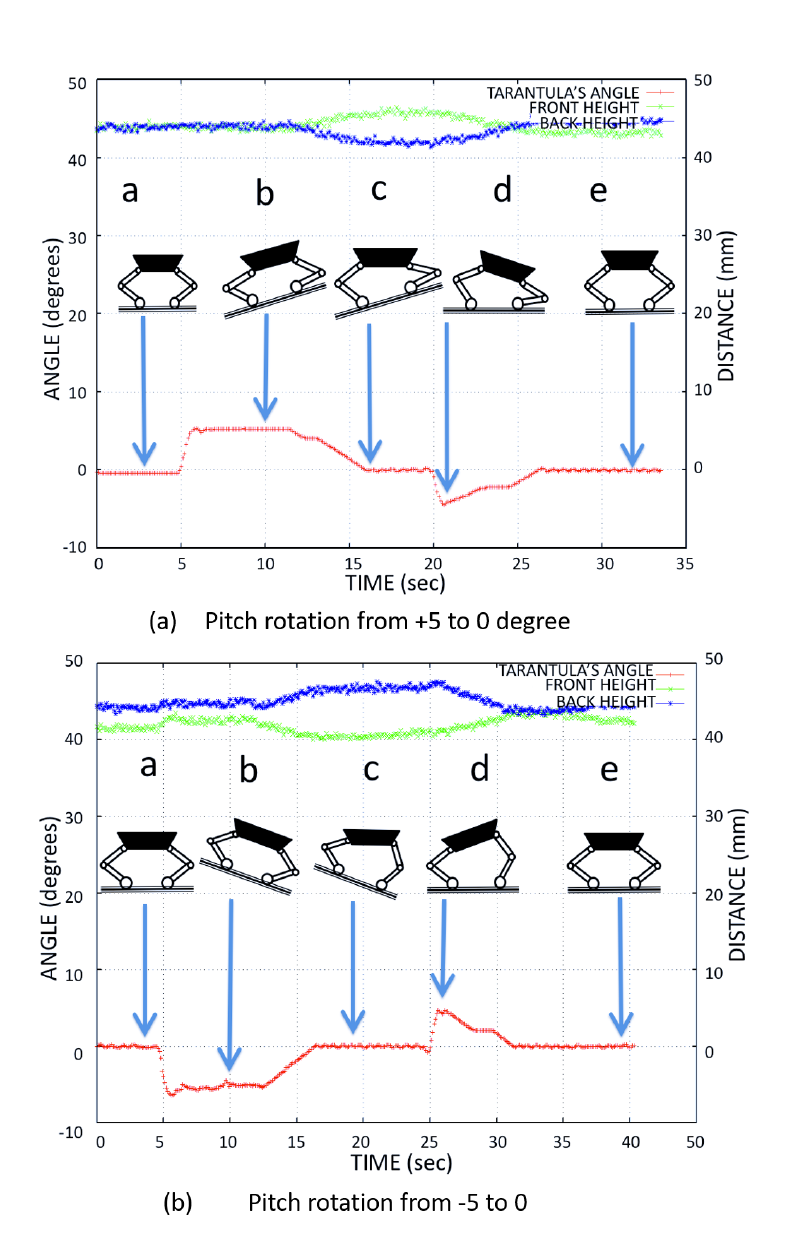
Figure 17. The Tarantula leg heights used for body balance during ( a ) 5 ◦ and ( b ) − 5 ◦ tilt angles of the